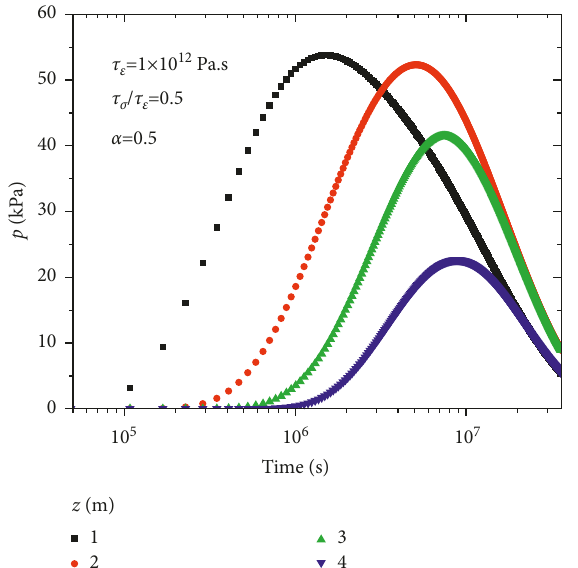
Figure 12: Influence of embedment depth on pore water pressure when τ